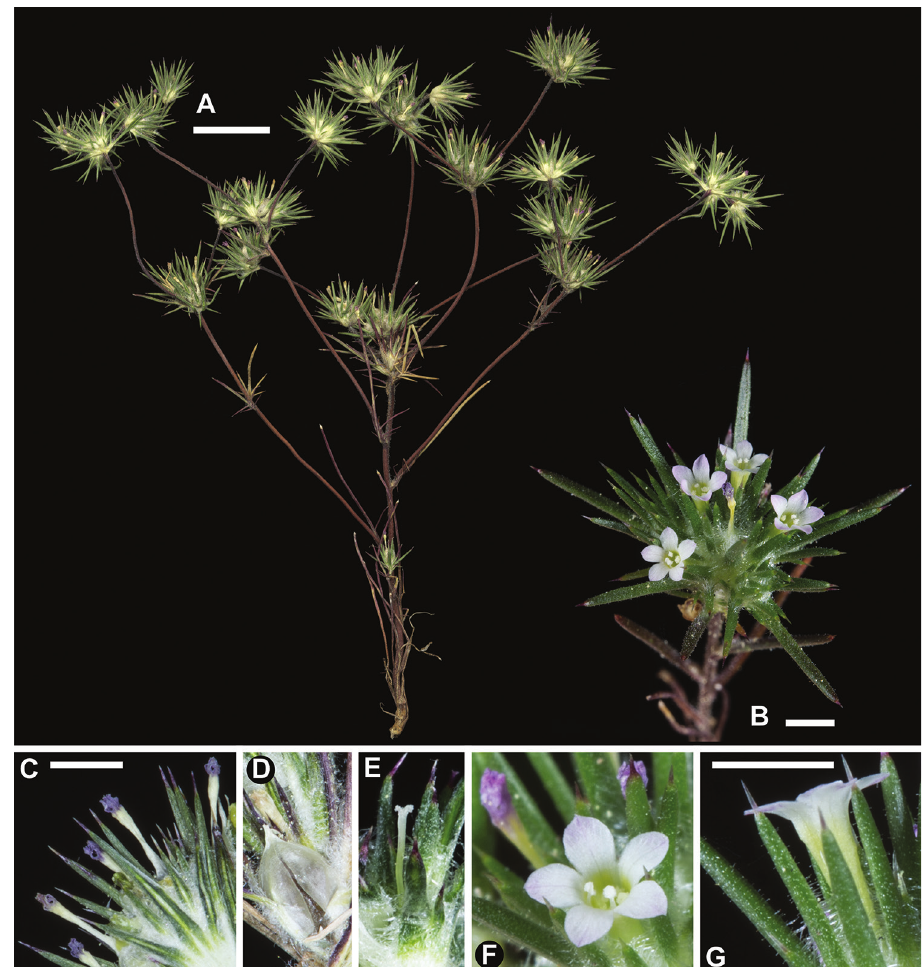
Figure 1. Navarretia divaricata . A Pressed specimen showing plant habit, scale bar = 1 cm ( Johnson 14- 143 ) B Flowering head in the field, scale bar = 2 mm ( Johnson 15-045 ) C–E Equivalent magnification, scale bar = 2mm C Pressed flowering head showing typical coloration of dried flowers ( Johnson 16-024 ) D Dried fruit, showing dehiscence from base upward typical in all of the species detailed herein ( Johnson 16-024 ) E Fresh flowering head dissected with corolla removed to show style and two-lobed stigma (with third lobe nearly entirely fused to one of the two apparent lobes; Johnson 16-024) F, G Fresh flowers showing typical coloration (Johnson 15-045), equivalent magnification, scale bar = 2 mm. All photographs by L. A. Johnson and vouchers deposited at